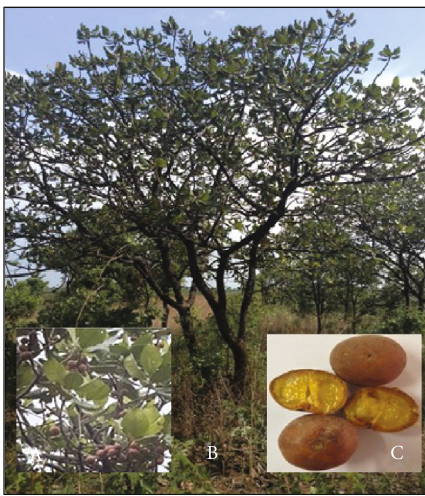
Figure 2: U. kirkiana fruits (a), U. kirkiana fruit trees (b), and U. kirkiana fruit pulp and seed (c).